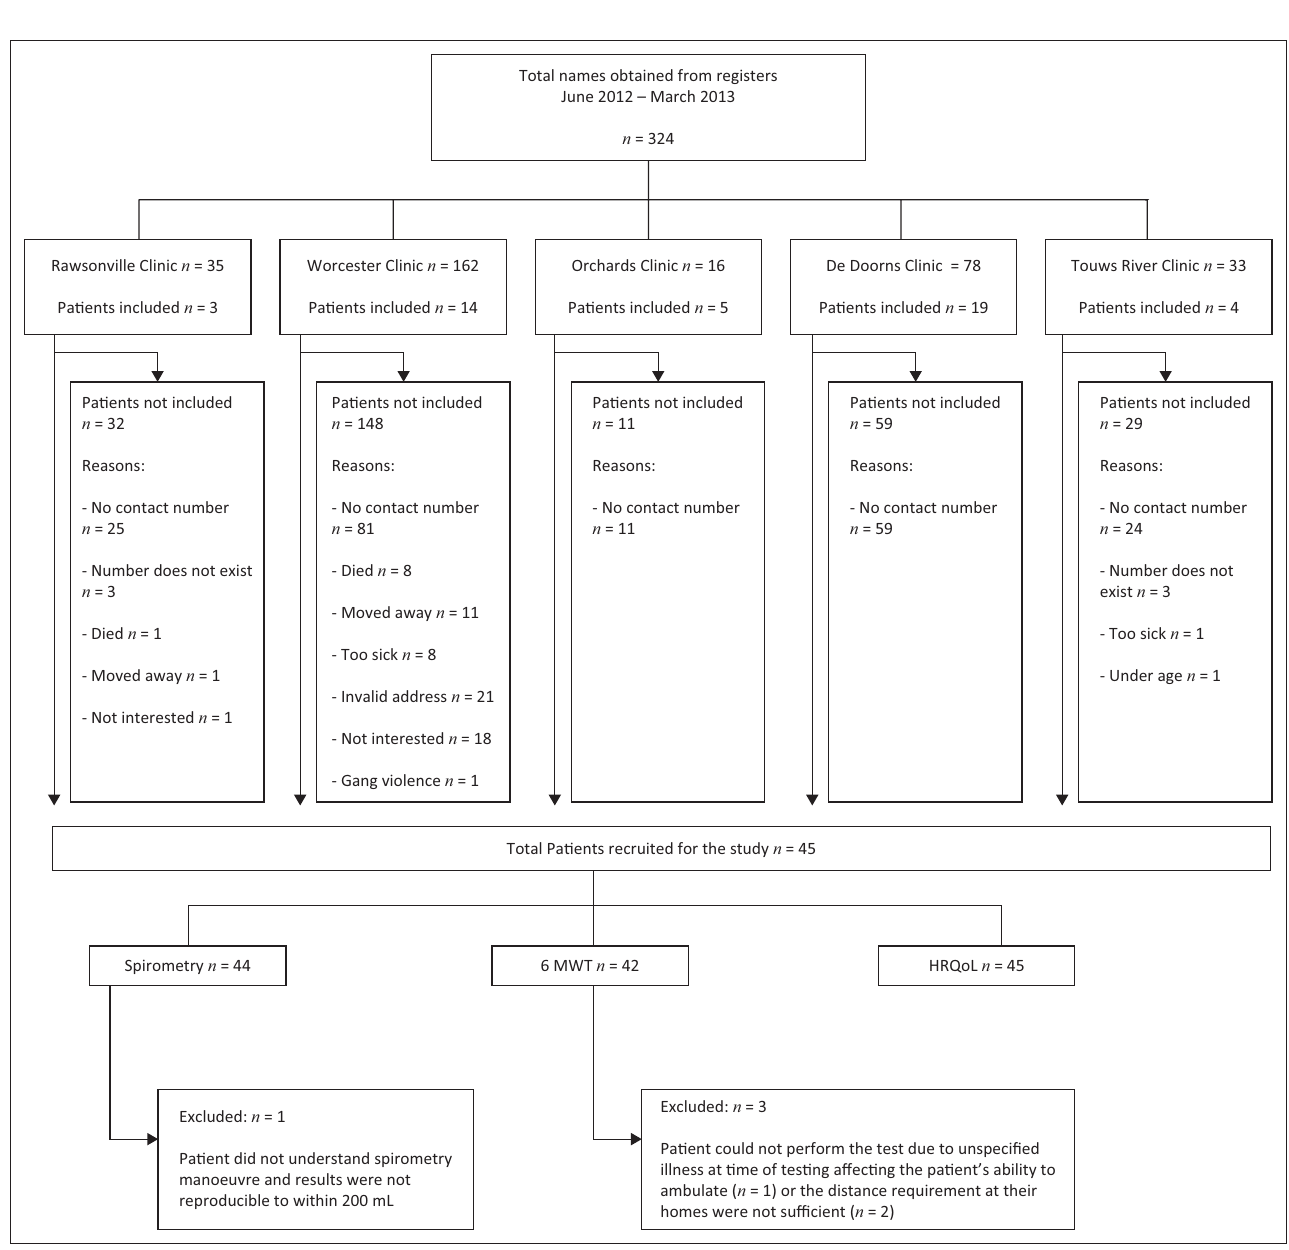
FIGURE 2: Flow diagram of patients included and excluded from the